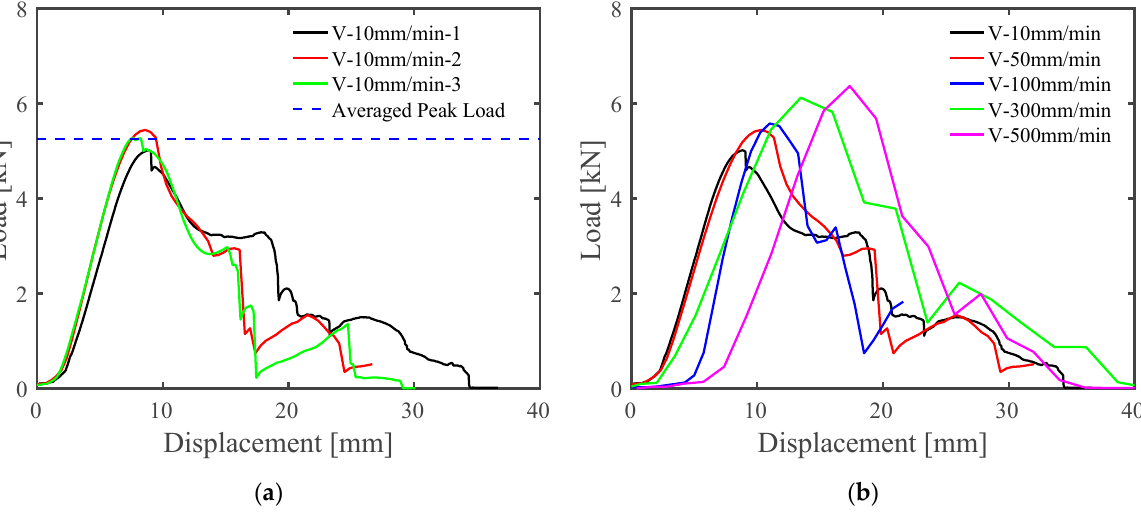
Figure 3. Experimental results for load vs. vertical displacement behavior ( a ) at 10 mm/min speed and ( b ) at various speed loads from 10 mm/min to 500 mm/min.